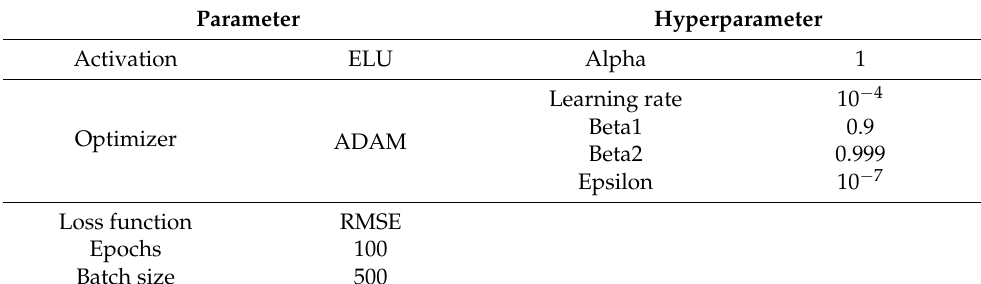
Table 3. Parameters and hyperparameters of the multilayer perceptron (MLP)